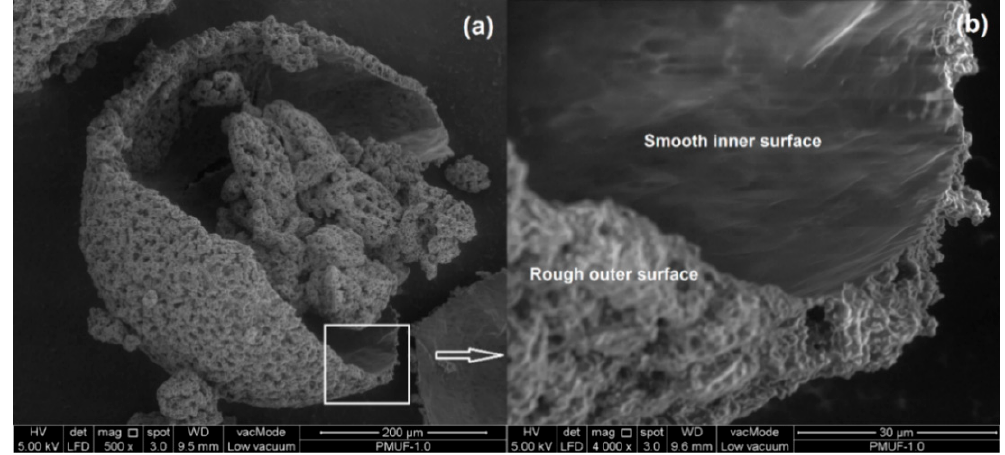
Figure 12. FESEM micrograph of a ruptured microcapsule at: ( a ) 500×; and ( b ) 4000× magnifications.